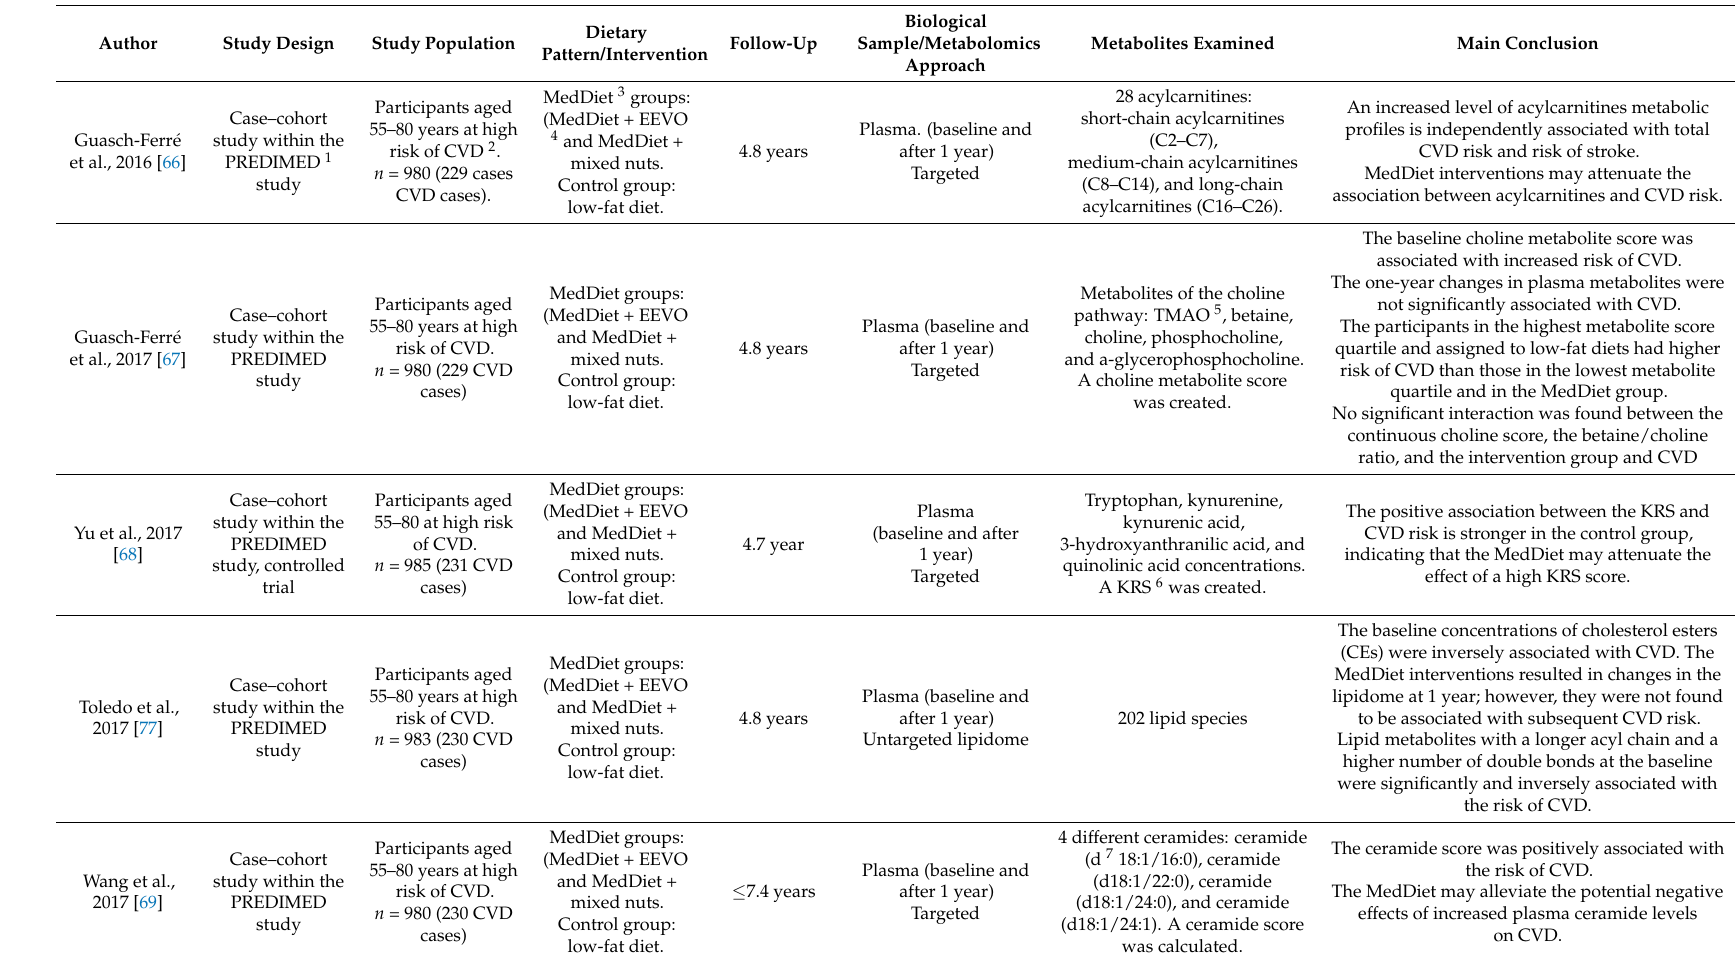
Table 2. Metabolomics, the Mediterranean diet pattern, and its association with CVD and